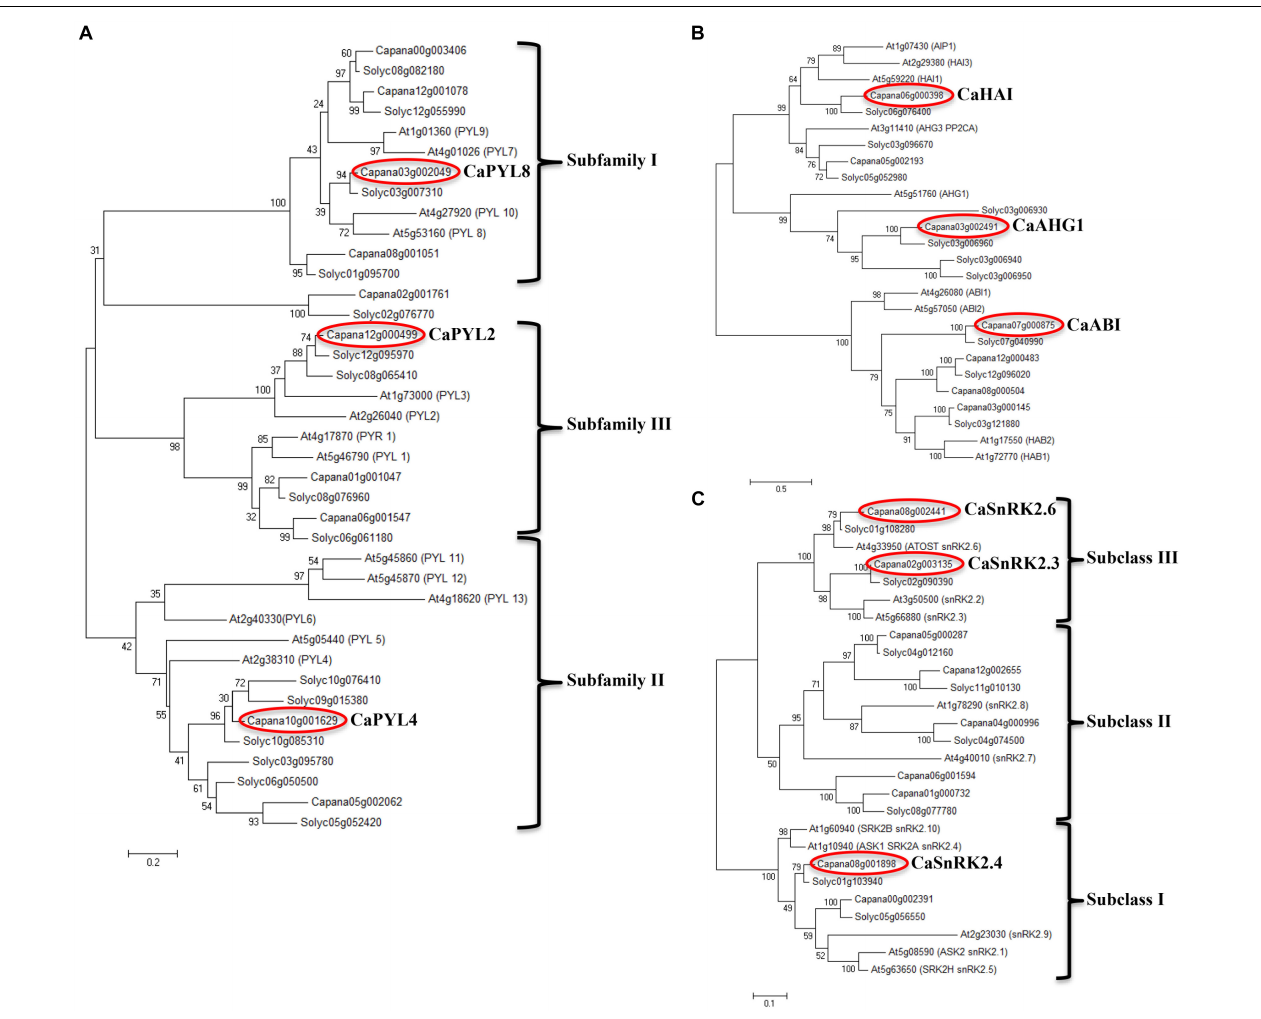
FIGURE 3 | Unrooted phylogenetic trees of the core components in ABA signaling: PYR/PYL/RCAR ( PYL ) (A) , clade A PP2C (B) , and SnRK2 (C) gene families. Trees were drawn using the maximum likelihood method in the MEGA V6 software. Red circles indicate genes selected for further experiments.